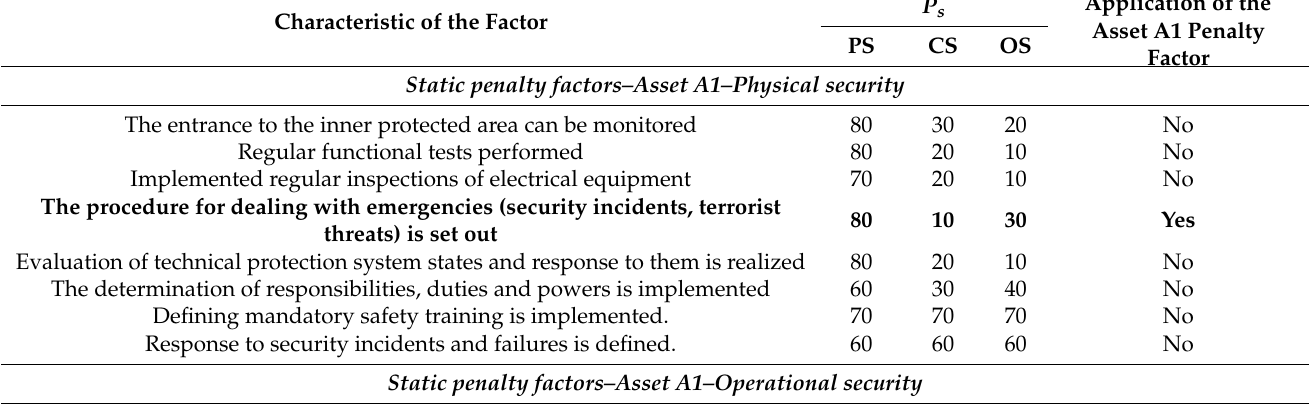
P s Application of the Asset A1 Penalty FactorPS CS